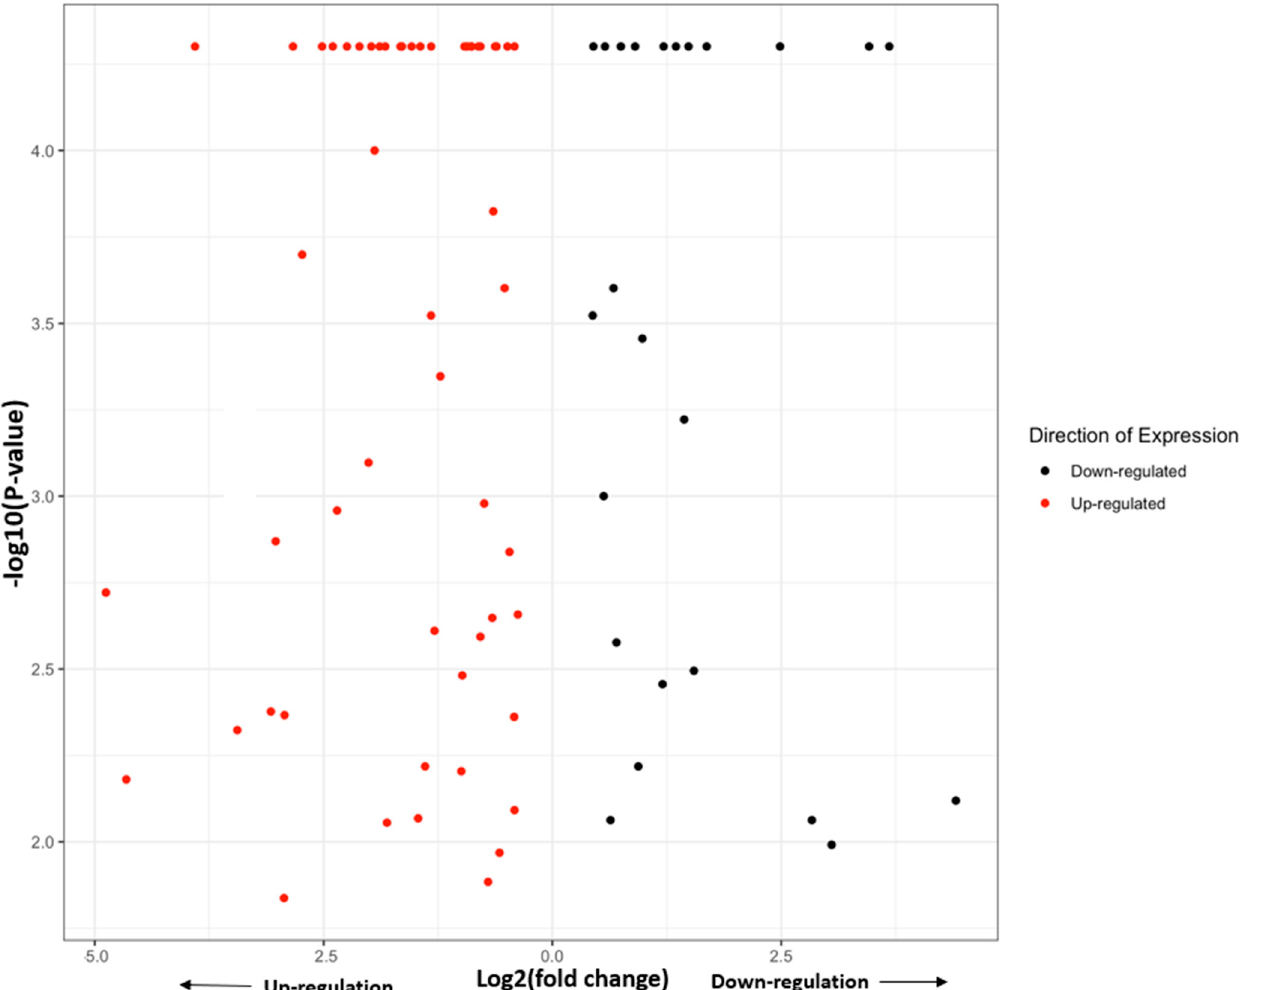
Figure 1. Log2 fold change in differentially expressed up-(red dots) or down-(black dots) regulated putative lncRNAs. The X-axis depicts the magnitude of log2 fold change in Bt-resistant H. zea where values on the left of 0.0 indicate the fold upregulation and on the right of 0.0 the log2 fold downregulation in the Bt-resistant strain of H. zea . The Y-axis is the p -values for statistical significance.